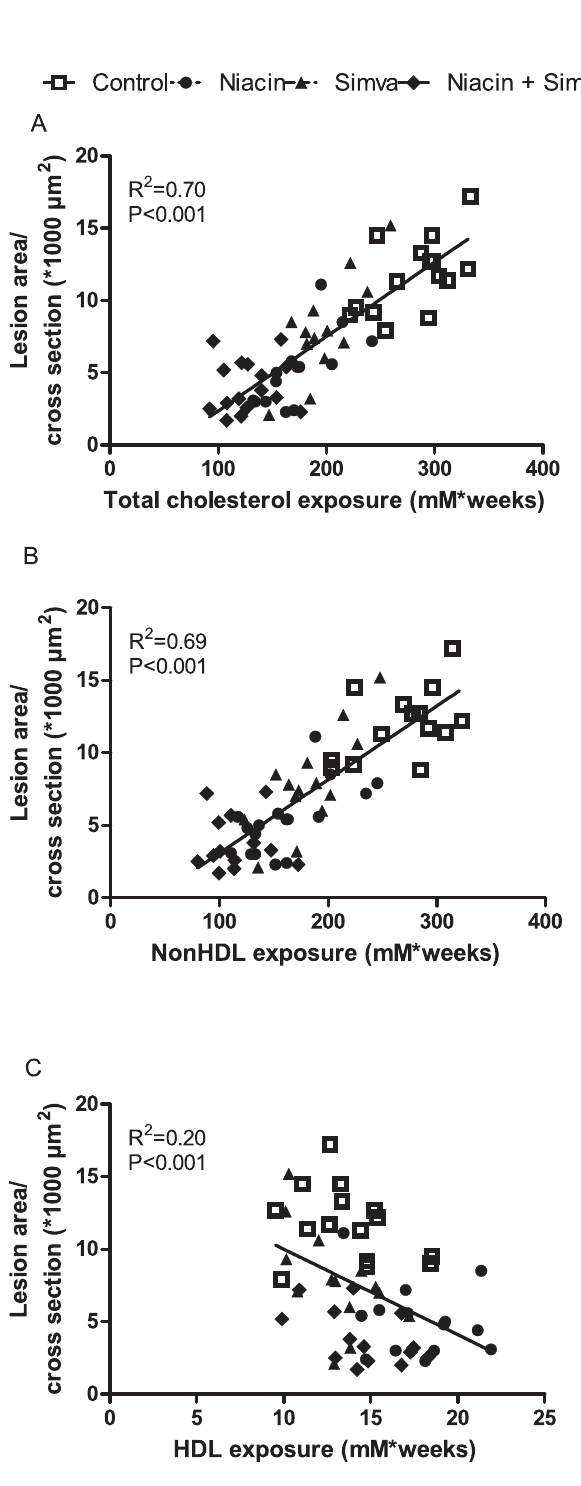
Figure 7. Correlation between plasma cholesterol exposure and lesion area. The square root of the lesion area was plotted against total cholesterol exposure (A), nonHDL-cholesterol exposure (B) and HDL-cholesterol exposure (C). Linear regression analyses were performed. (Simva, simvastatin; n=15 per group).